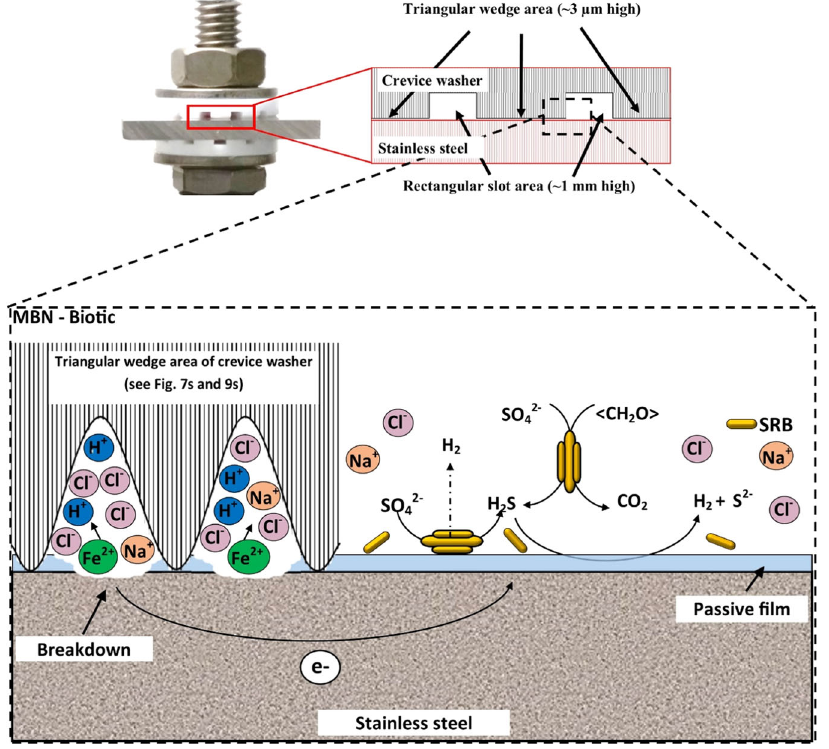
Fig. 10 Schematic diagram of proposed crevice corrosion mechanism of 304 stainless steel in MBN medium under biotic conditions. The fi gure shows crevice corrosion attack under the machined grooves in the triangular wedge area (average height ~3 µm and width ~48 µm) of the crevice washer that was in contact with the stainless steel